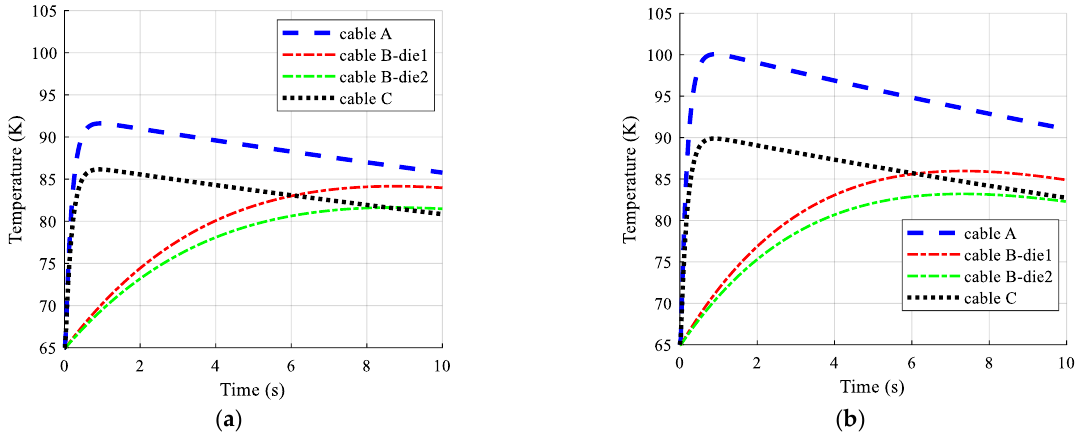
Figure 9. Temperature of the dielectric layer in each of the three HTS cables, ( a ) copper former, ( b ) aluminum former.